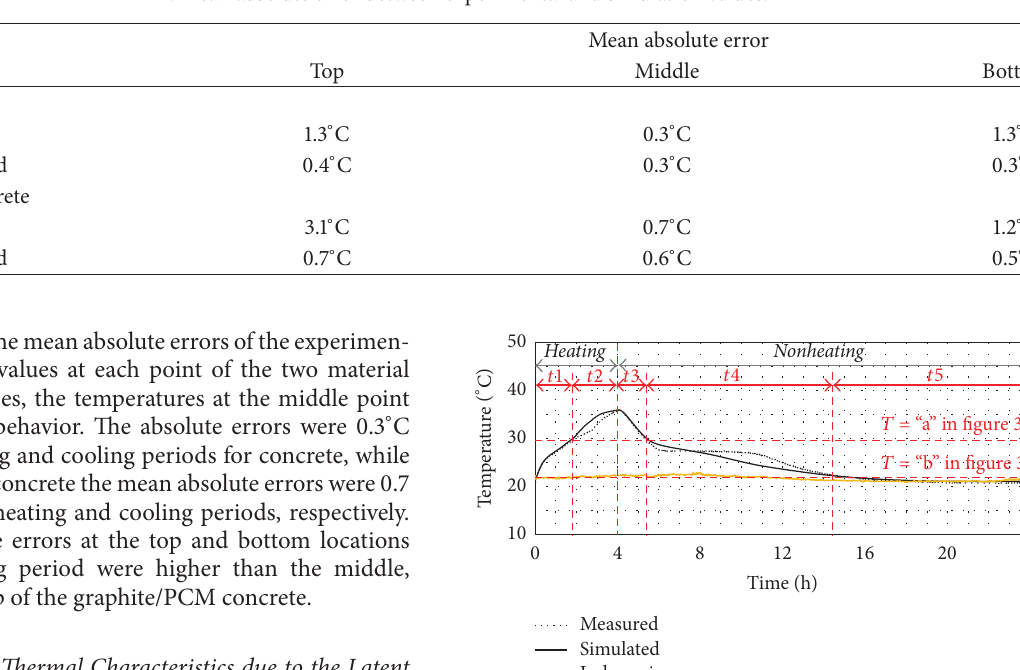
Table 4: Mean absolute error between experimental and simulation values.